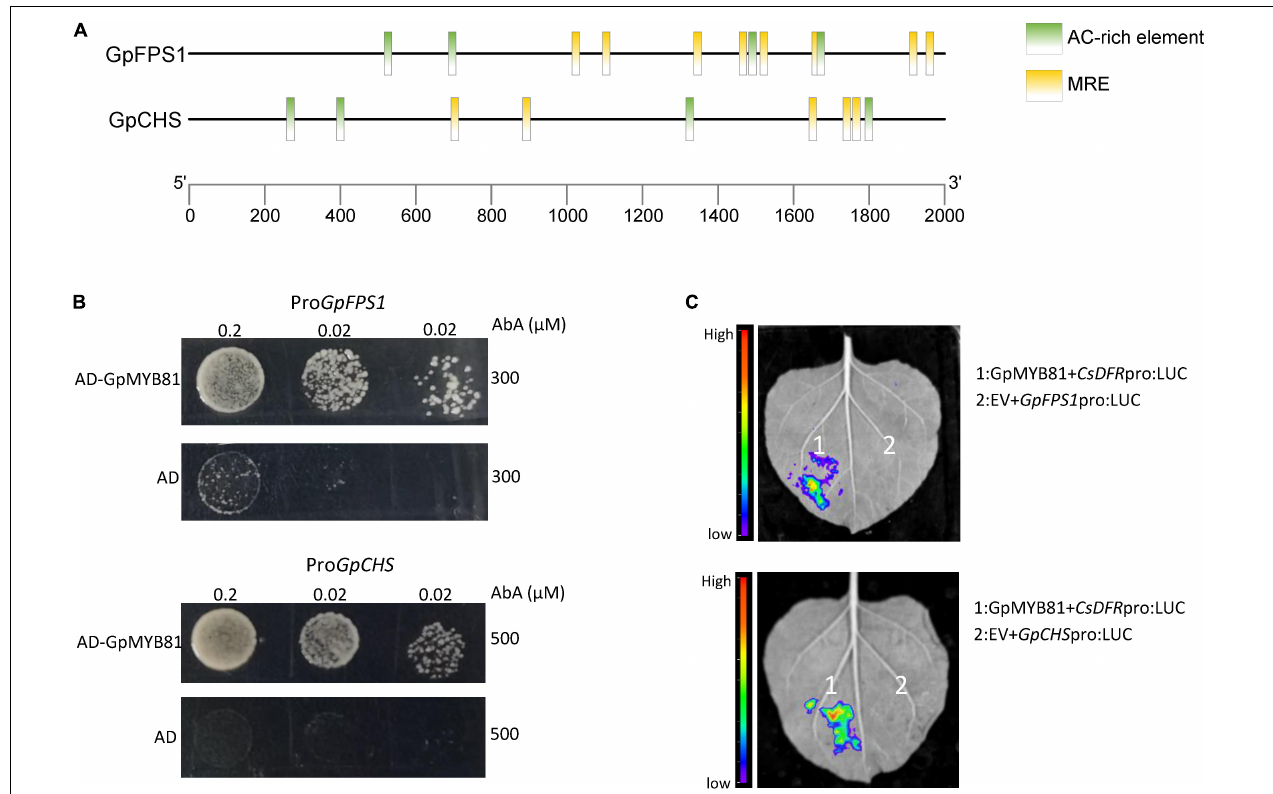
FIGURE 7 | Binding of GpMYB81 to GpFPS1 and GpCHS promoters and activation of their expression. (A) Schematic diagram of GpFPS1 and GpCHS promoters. The MYB-recognition elements (MREs) and AC-rich elements, identified with manual inspection, are indicated by their respective labels. (B) Yeast one-hybrid assays reveal that GpMYB81 can bind to the promoters of GpFPS1 and GpCHS . (C) Dual-luciferase (LUC) assays in Nicotiana benthamiana leaves were performed using GpFPS1 and GpCHS promoters driving LUC as a reporter along with effector GpMYB81; the empty vector (EV) served as an internal control. These results showed that GpMYB81 can activate both GpFPS1 and GpCHS